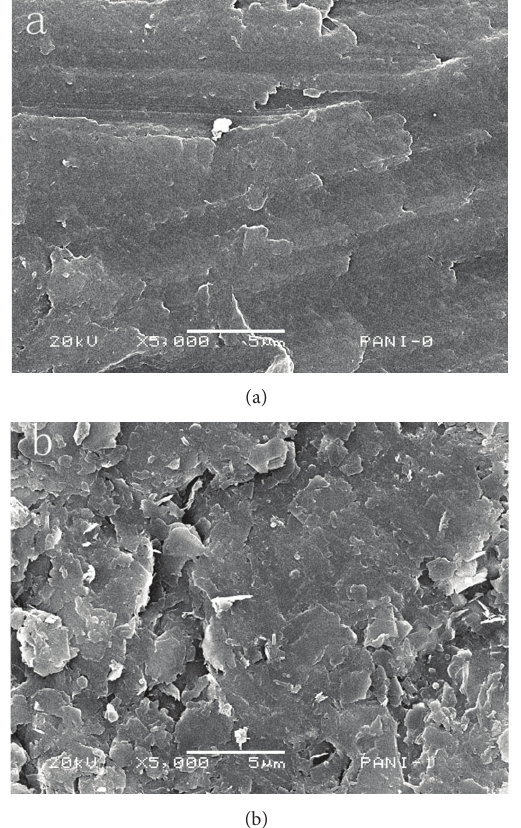
Figure 2: SEM of PAN (a) under atmospheric pressure and (b) at a pressure of 2.0 × 10 9 Pa. Table 1: Resistivity of doped PAN under atmospheric pressure. Doping type